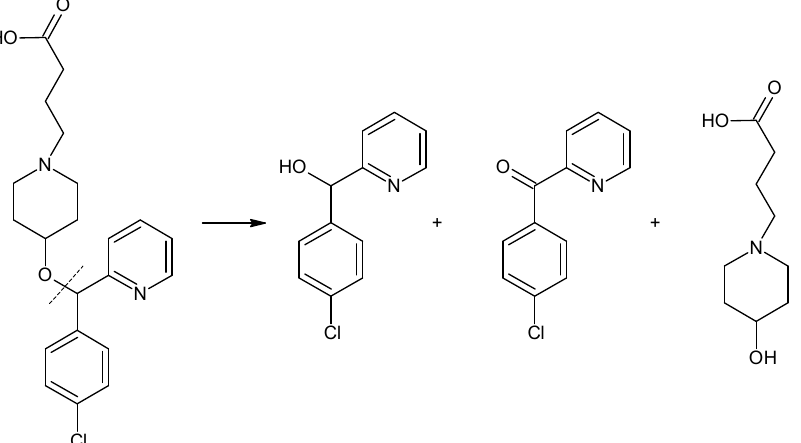
Figure 10. Hypothetical degradation of bepotastine (BEPO) under thermolytic and photolytic